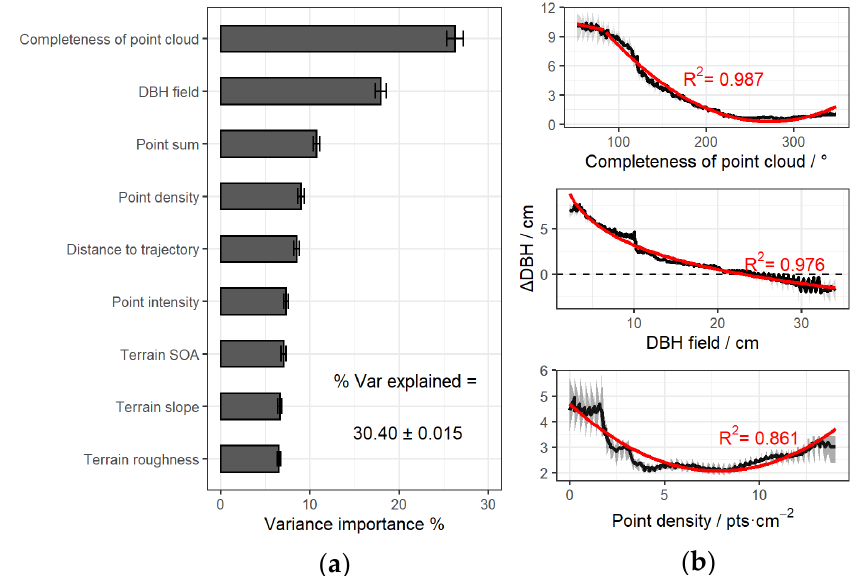
Table 1. Curve fitting for the marginal response of the DBH measurement error (ΔDBH) obtained with the random forest model. The table shows the F value and R 2 value for the model. Figure 3. Regression results obtained with the random forest model for the DBH measurement error ∆ DBH. ( a ) Relative importance of variables, where the error line is the standard deviation of the results obtained using the random forest model constructed by randomly drawing 80% of the samples 100 times. ( b ) Marginal response of the three most important variables, where the black lines are the average marginal response values obtained using the random forest model constructed by randomly drawing 80% of the samples 100 times. The upper and lower bounds of the gray shading are the maximum and minimum values, respectively, and the red curve is the best curve obtained by model screening based on R 2 .